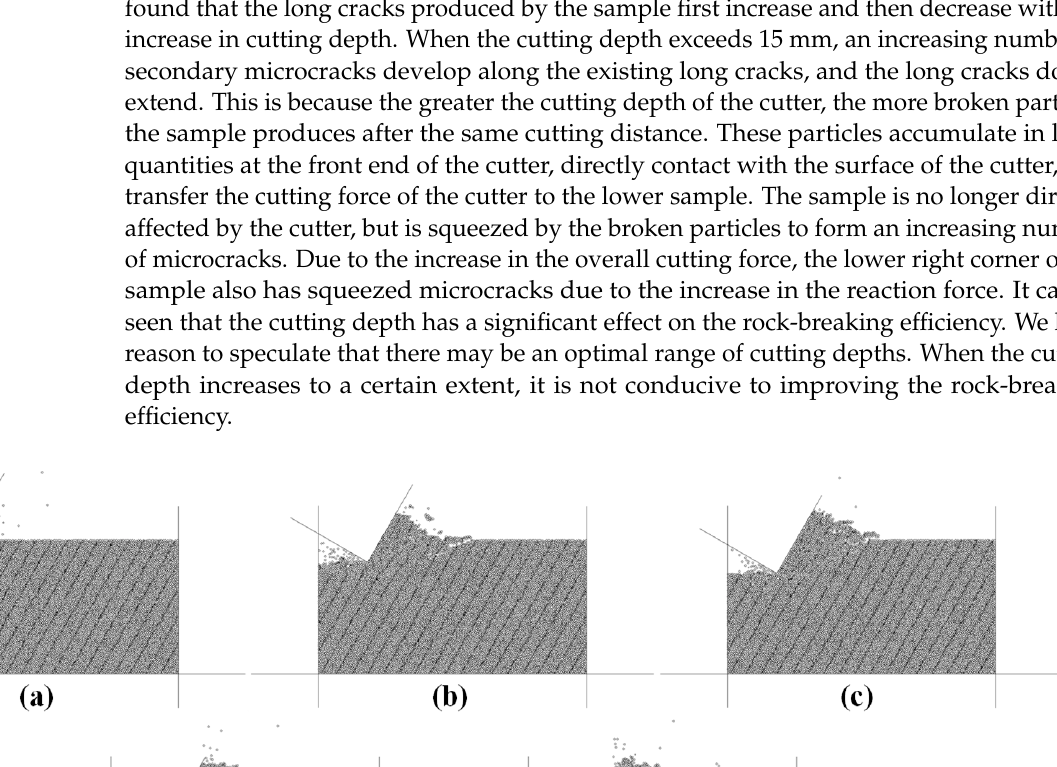
14 of 30 Figure 13. Variation characteristics of crack number of samples with different bedding thicknesses: ( a ) 2 mm; ( b ) 4 mm; ( c ) 6 mm; ( d ) 8 mm; ( e ) 10 mm. 3.3. Effect of Cutting Depth According to the simulation conditions shown in Table 3, we calculated the effect of cutting depth. Figure 14 shows the failure modes of samples with different cutting depths.